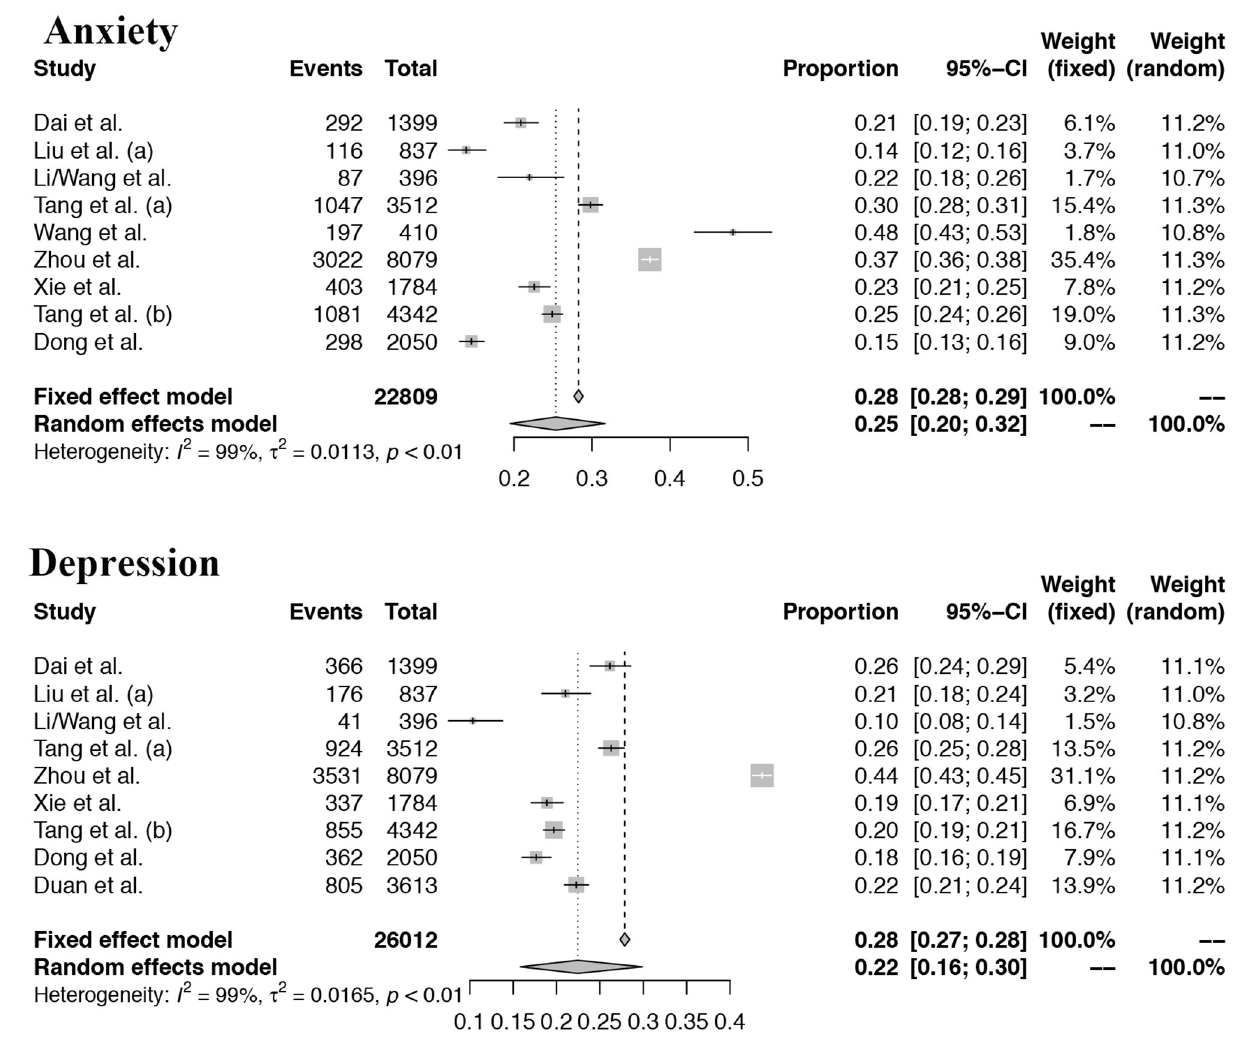
FIGURE 3 | Forest plots of the depression and anxiety